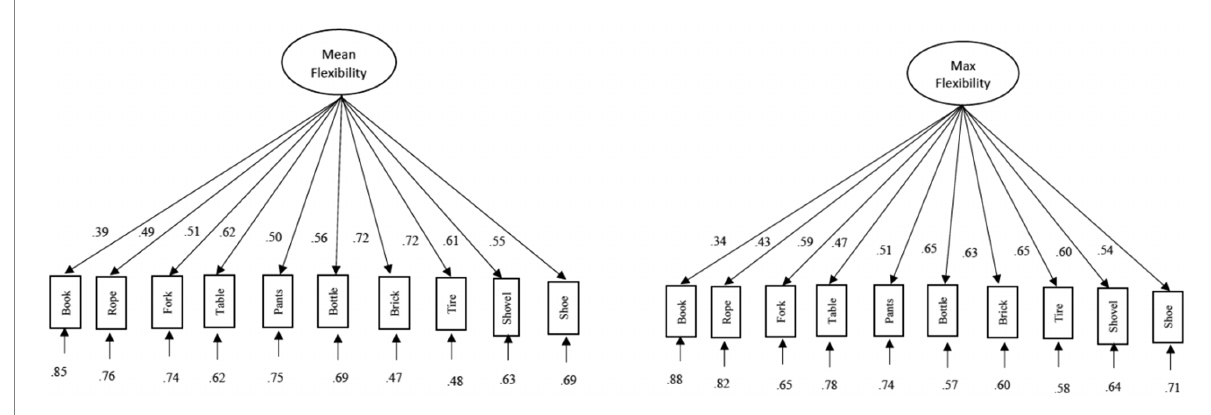
FIGURE 3 Path diagram of mean and maximum flexibility scoring.